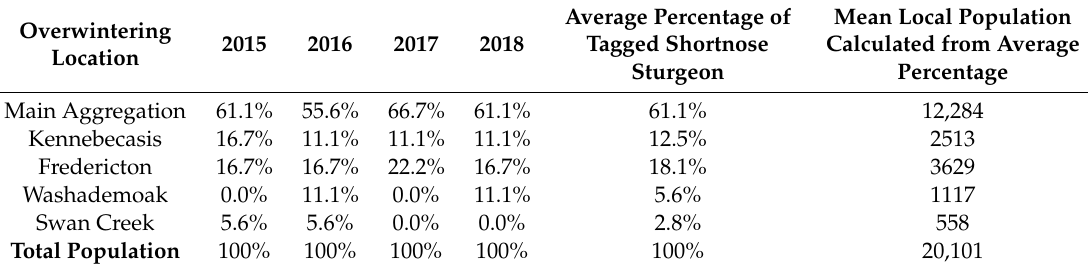
Figure 8. Four screenshots from the underwater video footage. The head shape can be used to identify a Shortnose Sturgeon ( Acipenser brevirostrum ) ( A , B ) from Atlantic Sturgeon ( Acipenser oxyrinchus ) which co-occurs in the Saint John River. Sometimes multiple Sturgeon were observed at the same time and they were typically laying on the substrate unless disturbed by the camera ( C ). The substrate was sand with sparse mussel shells ( D ). Table 1. Percentage of tagged Shortnose Sturgeon ( Acipenser brevirostrum ) occupying each overwintering location across four years calculated from acoustic tracking data as well as the mean population calculated for each location. Total population 20,101 was calculated by assuming that the 12,284 individuals identified in the main aggregation represent 61% of the total Shortnose Sturgeon population in the Saint John River, New